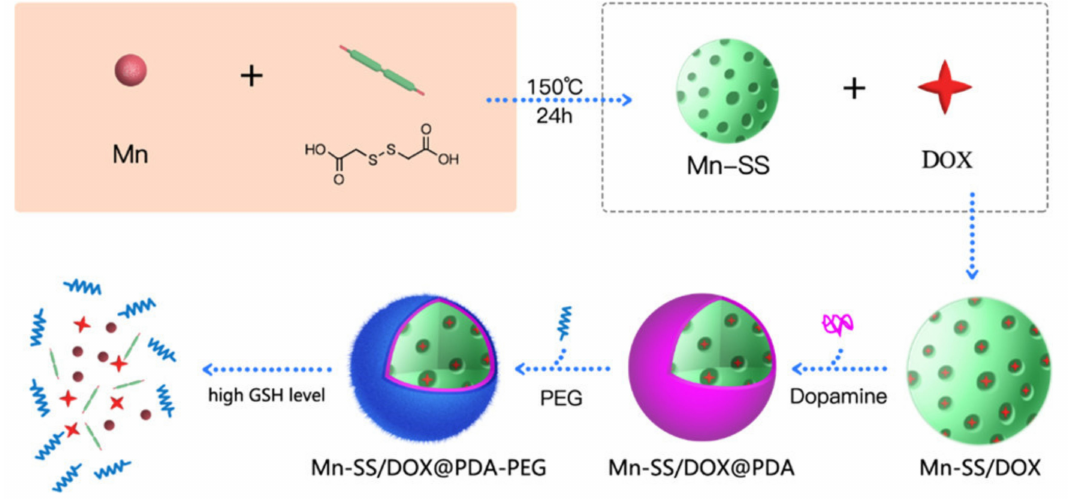
Figure 3. Synthesis and characterization of Mn-SS NCPs, as well as the GSH, triggered nanoparticle decomposition, drug release, and Mn 2+ -enhanced MRI. Adapted from ref [27], with permission from Copyright © 2017, American Chemical